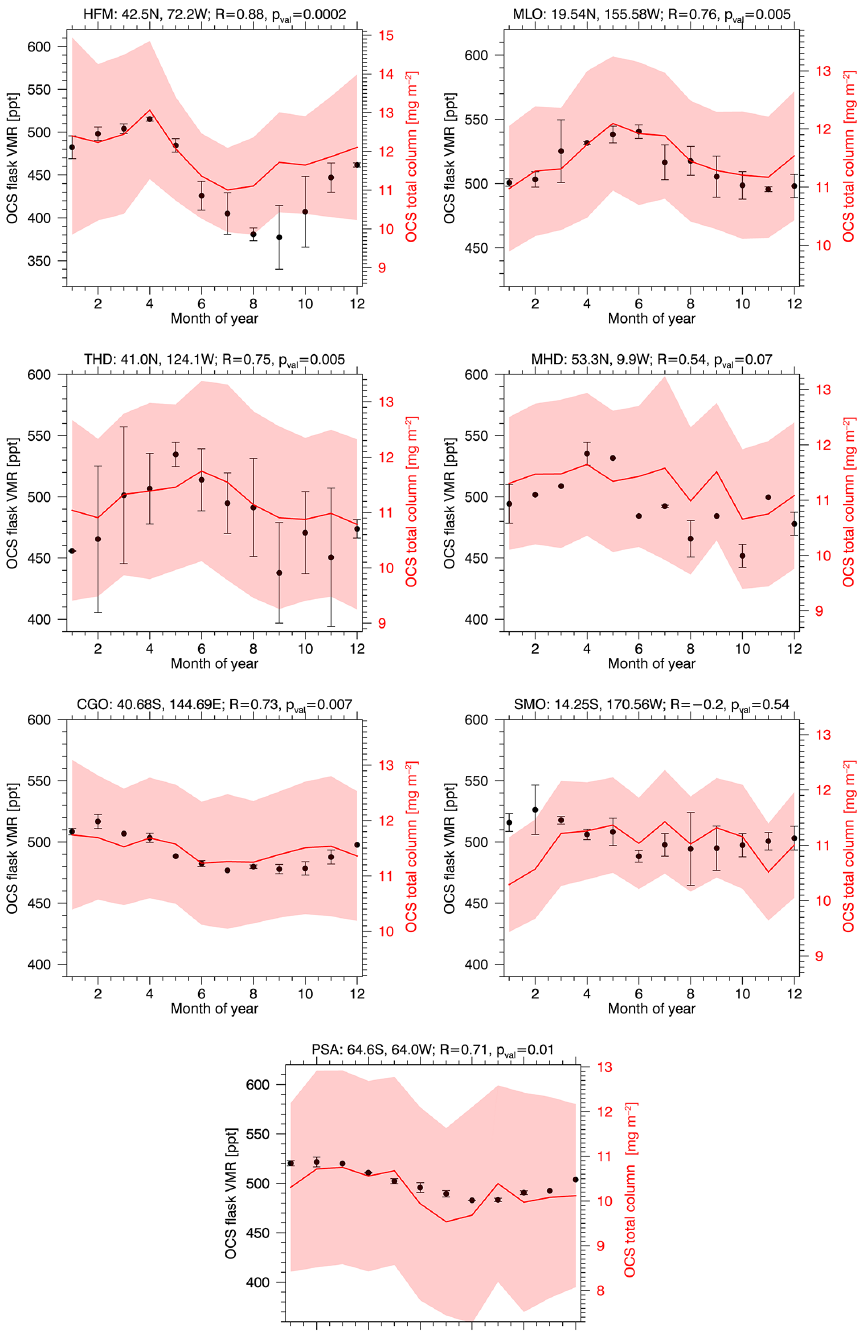
Figure 17. OCS total column median estimates (red) from the linear retrieval are compared to NOAA flask measurements of OCS surface VMR (black) binned by 12-month increments throughout 2014. Retrieval estimates are taken from a 2 ◦ radius about the NOAA site locations. The shaded red area represents the sample standard deviation of the total column estimates and the black error bars are the standard deviation of the flask samples within that month ( not divided by the square root of the sample